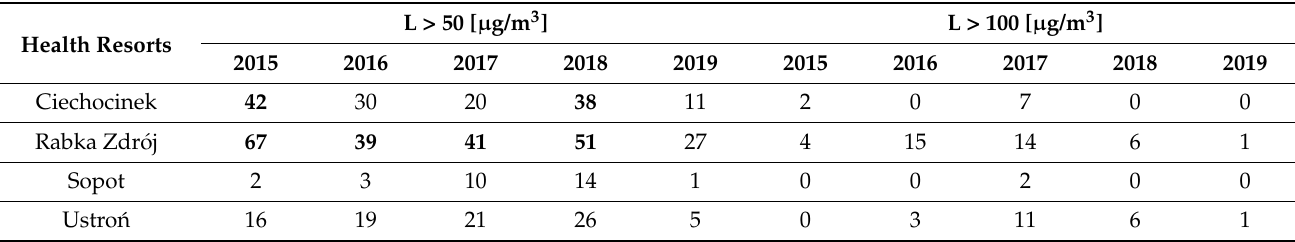
Table 6. The number of days with exceedances of the limit value PM 10 (L > 50) and (L > 100) in the health resort surveyed in